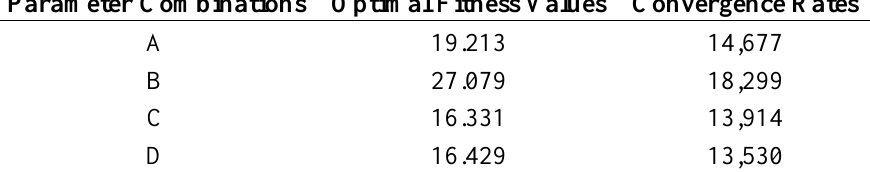
Table 6. Optimal fitness values of ( ) E s and convergence rates of the SA under different parameter combinations.